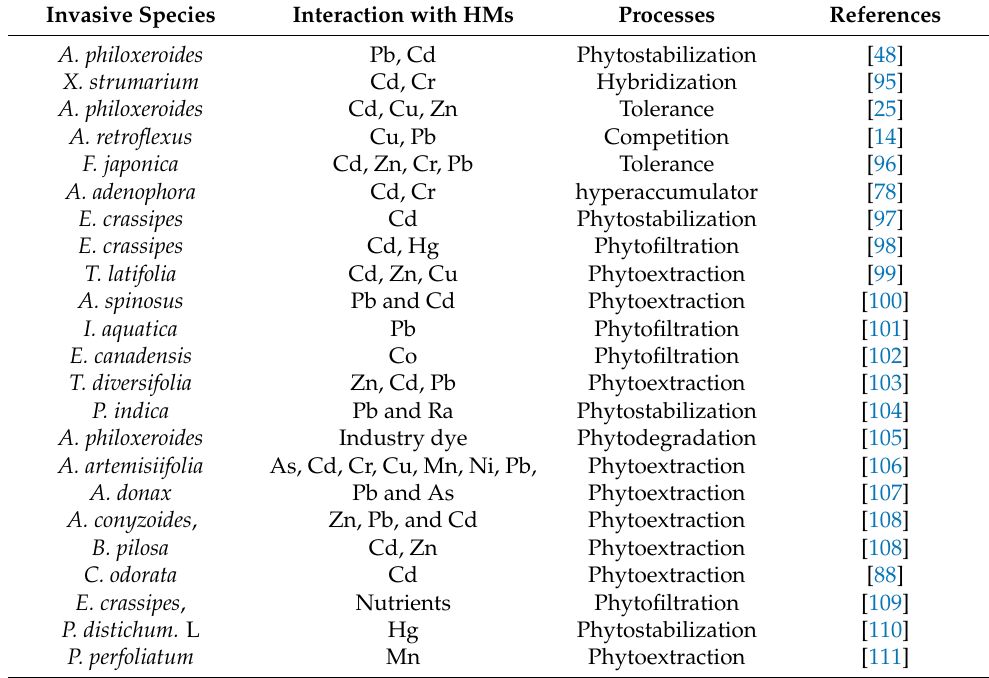
Table 1. Correlation of IPS with HMs and appropriate